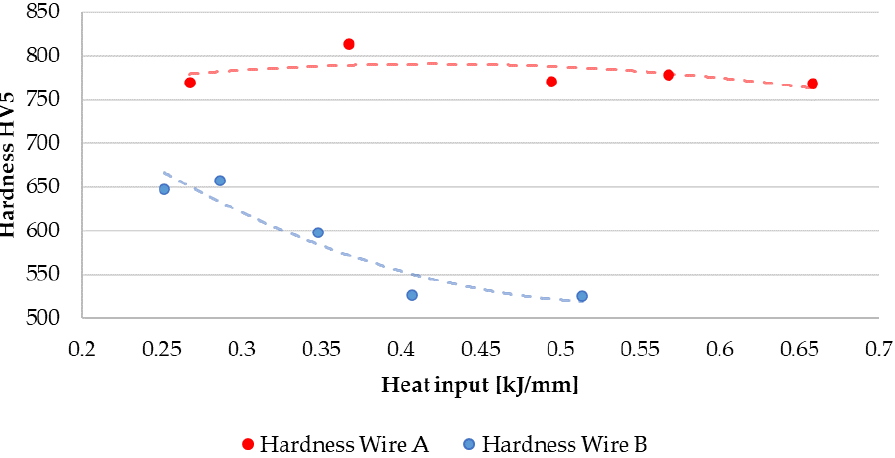
Figure 13. Graph of mean hardness values for Wire A and Wire B for given heat input levels. While Wire A exhibits relatively stable hardness value, the hardness of Wire B is vulnerable against the heat input level. The red and blue dashed lines express the second order interpolation.